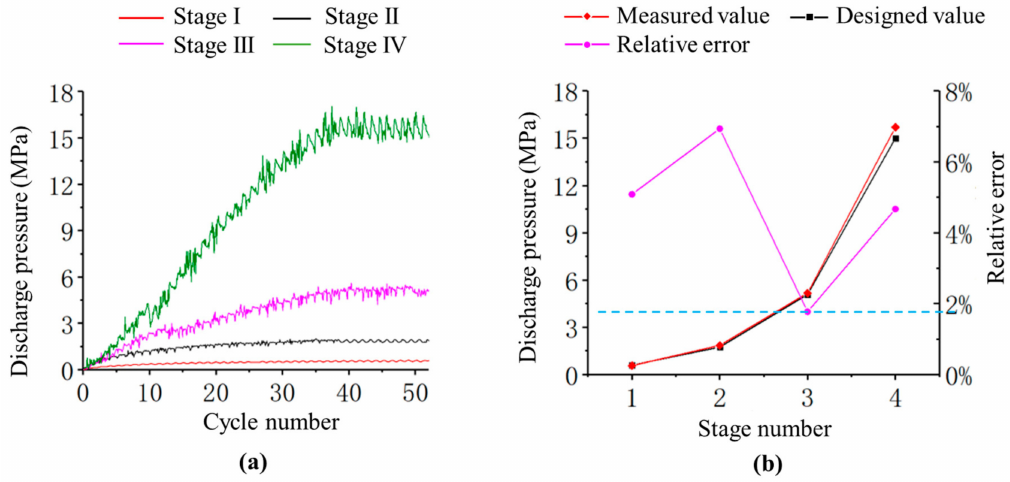
Figure 16. Comparison of ( a ) the discharge pressures and ( b ) the relative errors in all